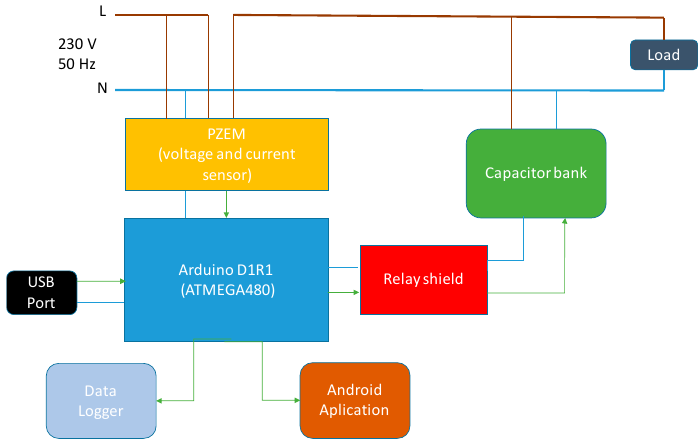
Figure 3. Power Factor Compensation and Monitoring System (PFCMS) scheme.